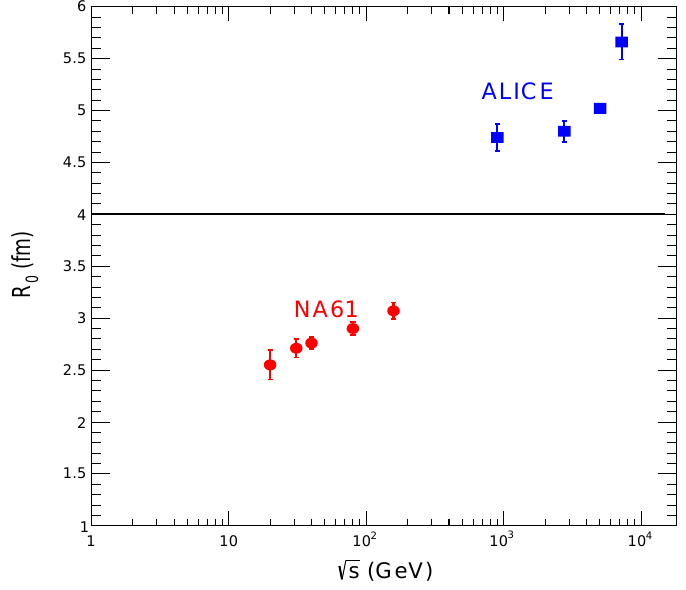
Figure 4. The energy dependence of the freeze-out radius R 0 of pions in pp collisions. The round (red) points are obtained from fits to the results of the NA61/SHINE Collaboration [14] (see Table 4), the square points are for the ALICE Collaboration data (see Table 1). The straight line at R 0 = 4 fm is there to guide the eye only.